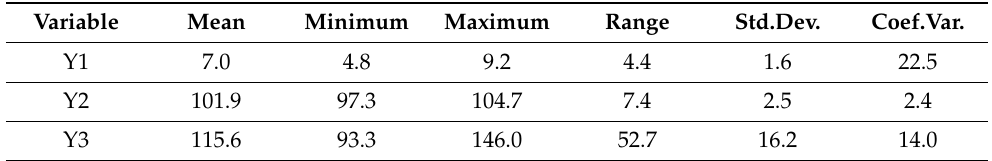
Table 2. Descriptive statistics (in